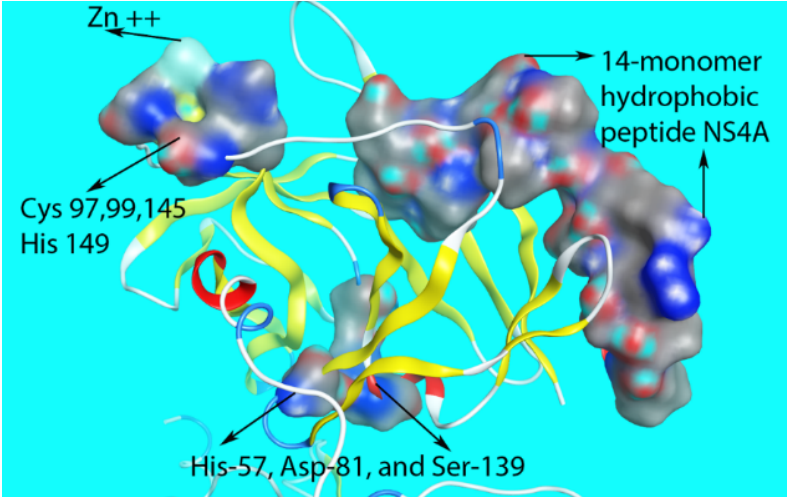
Figure 2. NS3/4A protease Active Site: The active site configuration of NS3/4A protease comprises the residues His-57, Asp81, and Ser-139 and that NS3 protease requires the vital 14-monomer hy- drophobic peptide NS4A for its activation. The zinc ion is coordinated by three cysteine residues, Cys97, 99, 145, and a His 149 through a water molecule and is located opposite to the active site.